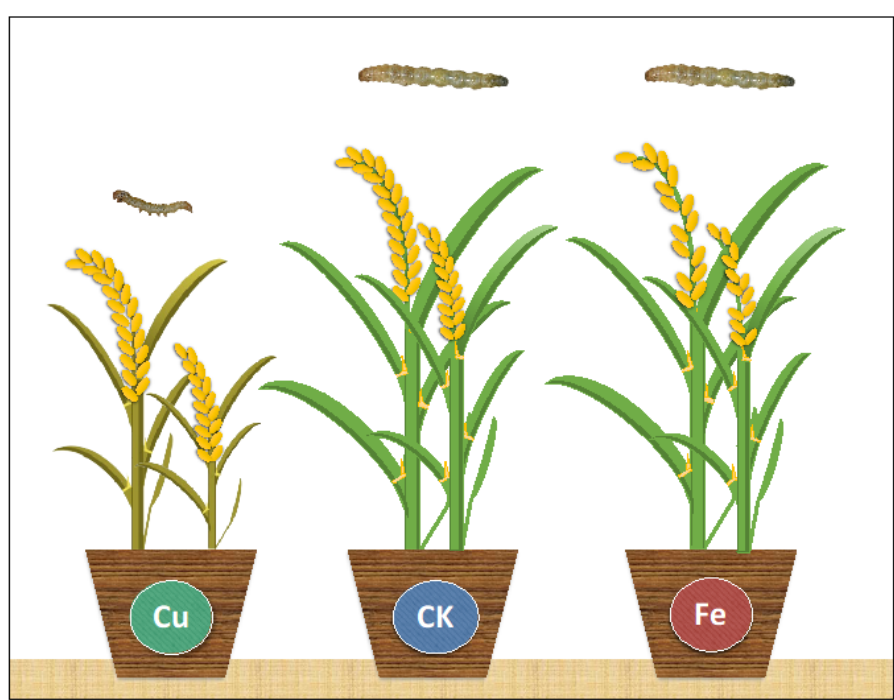
Figure 5. Summary of the elemental defense potential of Cu and Fe against the C. medinalis . High levels of Cu impede the growth and development of C. medinalis but the elemental defense potential is limited because this treatment seriously affects the growth and development of rice plants at the vegetative and reproductive stages. High levels of Fe offer no elemental defense potential because the treatment does not affect the growth of C. medinalis but does inhibit root growth and reduce rice yields at the reproductive stage.